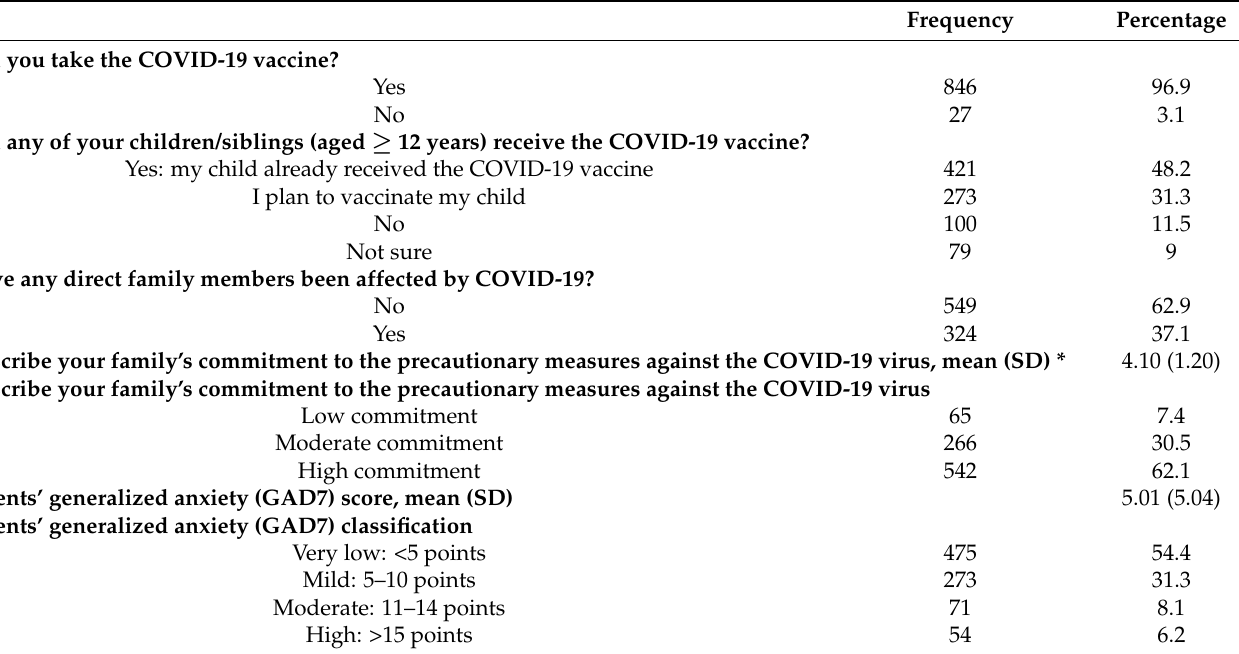
Table 2. Participants’ COVID-19 perceptions and uptake of the vaccine.